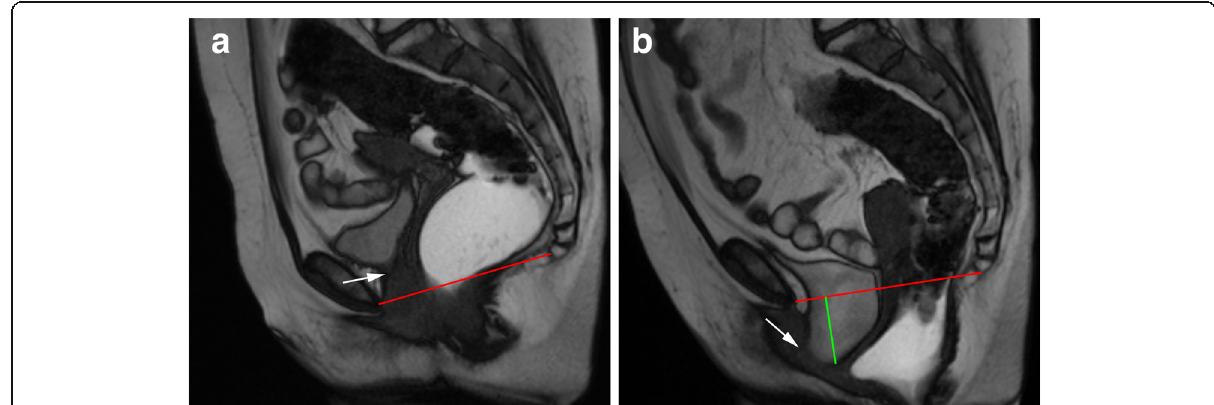
Fig. 10 Moderate cystocele with urethral hypermobility. ( a , b ) Sagittal midline TrueFISP images at rest ( a ) and during evacuation ( b ), demonstrating descent of the bladder during evacuation (green line — 3.8 cm) below the PCL (red line), as well as horizontalization of the urethral axis during defecation (white arrows). Note also an anterior rectocele in ( b